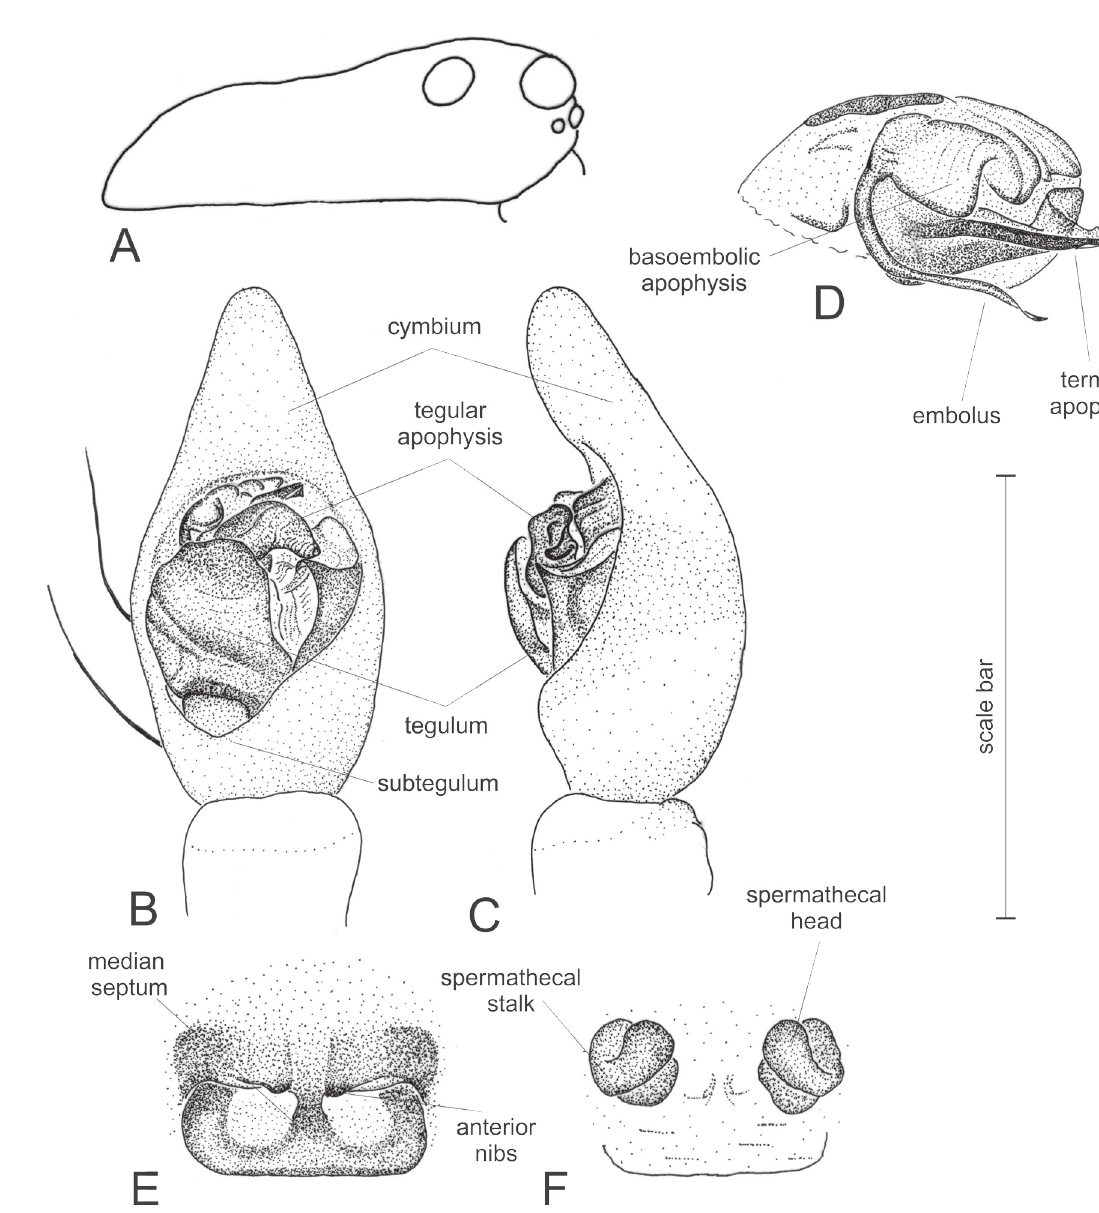
Fig. 15. Tetralycosa alteripa (McKay, 1976), ♂ (WAM T47354) and ♀, paratype (WAM T47356) . A . Male carapace, lateral view. B–C . Left male pedipalp, ventral and retrolateral view. D . Left male pedipalp, palea section of bulbus, ventral view. E–F . Female epigyne, ventral and dorsal view. Scale bar: A = 8.83 mm; B–C = 2.56 mm; D = 1.47 mm; E–F = 1.91